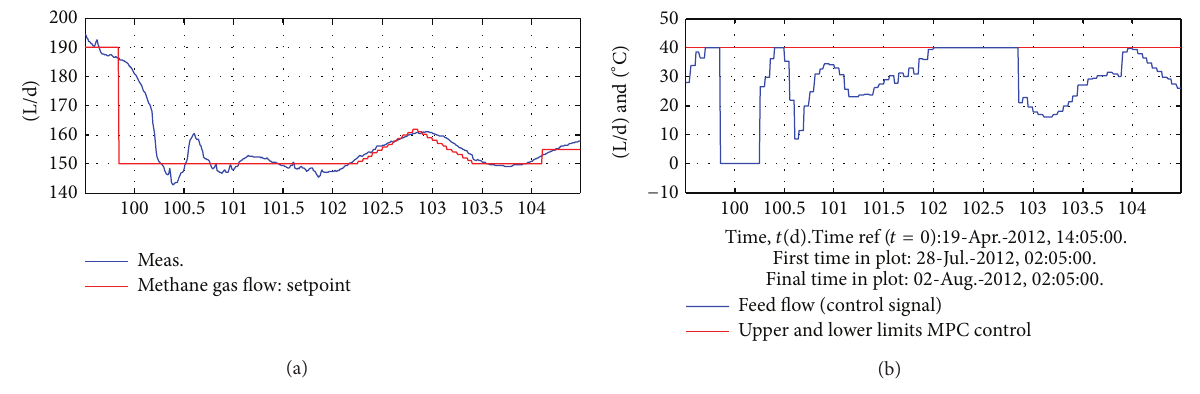
Figure 8: Time series from application of predictive control of 𝐹